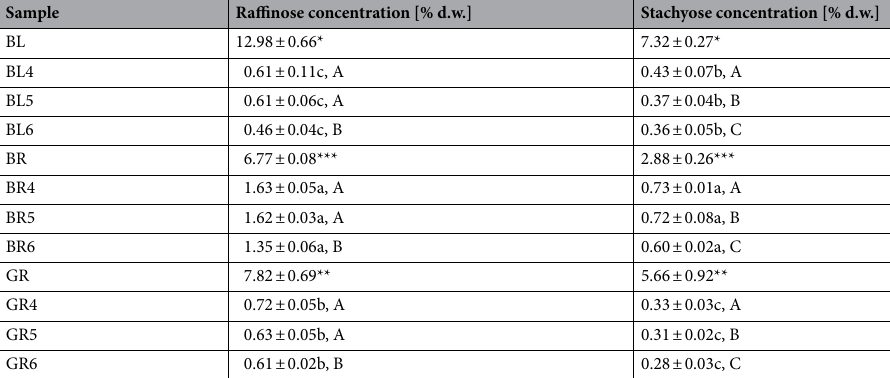
Table 1. Concentration of stachyose and raffinose in lentil seeds and lentil malts. Data are shown as means ± standard deviation (n = 4). Various small letters (a, b, c) indicate homogenous groups according to the variable ‘variety’, various capital (A, B, C) letters indicate homogenous groups between malts according to the variable ‘days of germination’, various number of asterisks indicate homogenous groups between unmalted seeds according to the variable ‘variety’ (Bonferroni test, α = 0.05). BL black lentil, BL4 malt from black lentil germinated 4 days, BL5 malt from black lentil germinated 5 days, BL6 malt from black lentil germinated 6 days, BR brown lentil, BR4 malt from brown lentil germinated 4 days, BR5 malt from brown lentil germinated 5 days, BRL6 malt from brown lentil germinated 6 days, GR green lentil, GR4 malt from green lentil germinated 4 days, GR5 malt from green lentil germinated 5 days, GR6 malt from green lentil germinated 6 days.